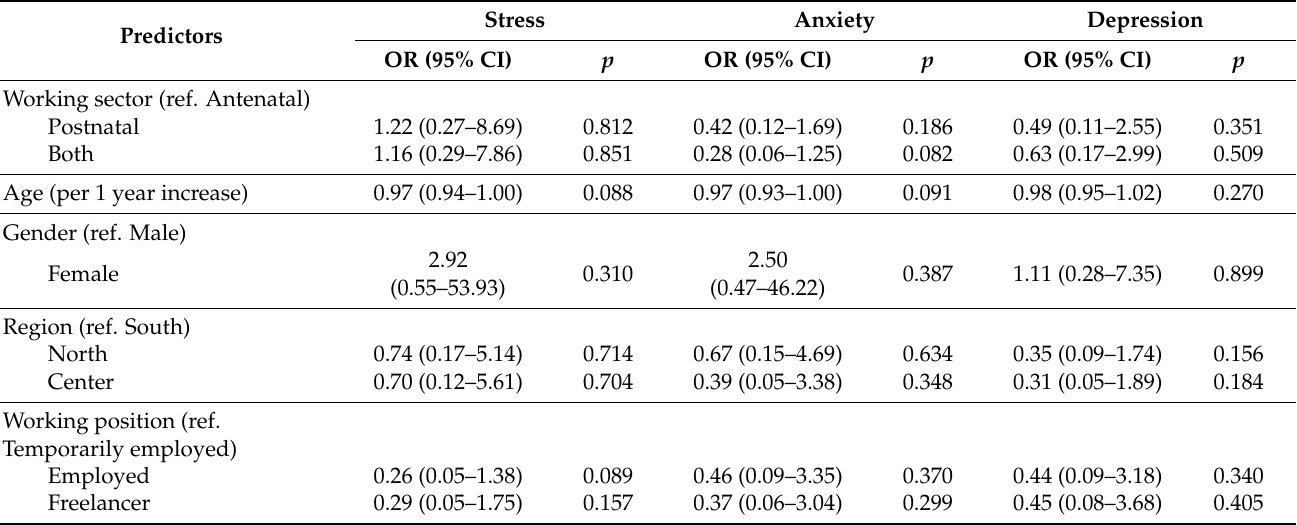
Table 3. Associations between demographic and occupational variables and stress, anxiety, and